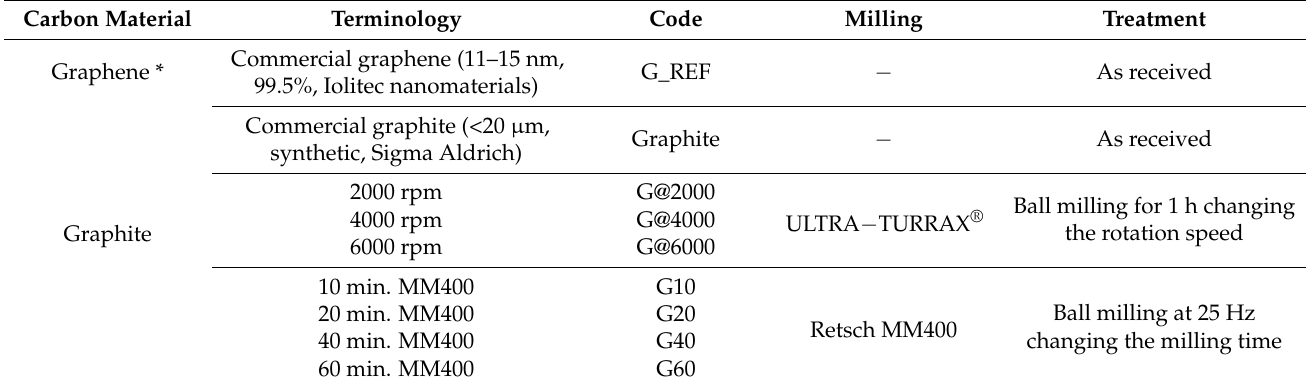
Table 2. Treatment for carbon modifications and respective